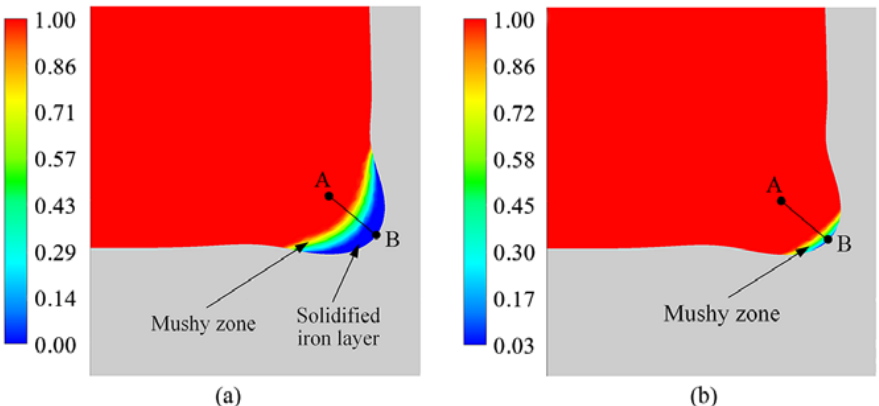
Figure 8. The volume fraction of hot iron on section C. ( a ) top lining structure. ( b ) model with 2 mm air gap.